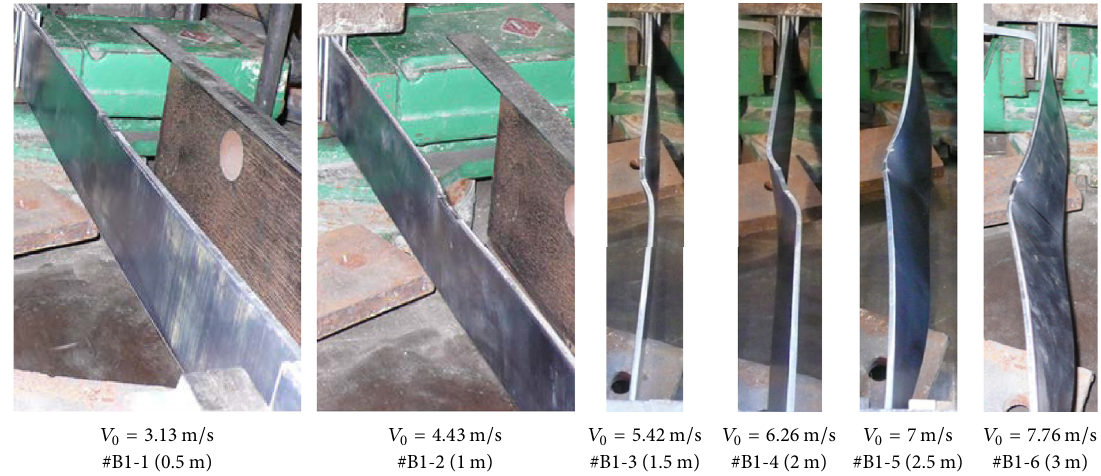
Figure 10: Deformation modes of #B1 (𝛼 = 14, 𝛽 = 10)